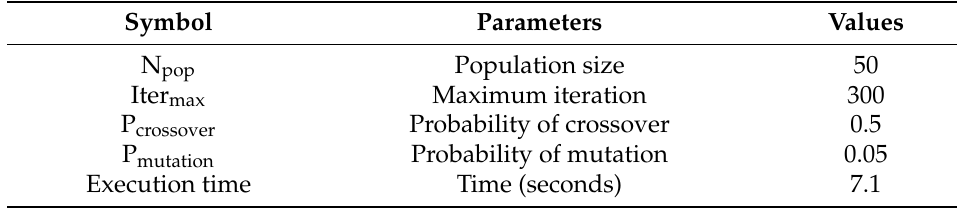
Table 5. Key simulation parameters used for the CGA.